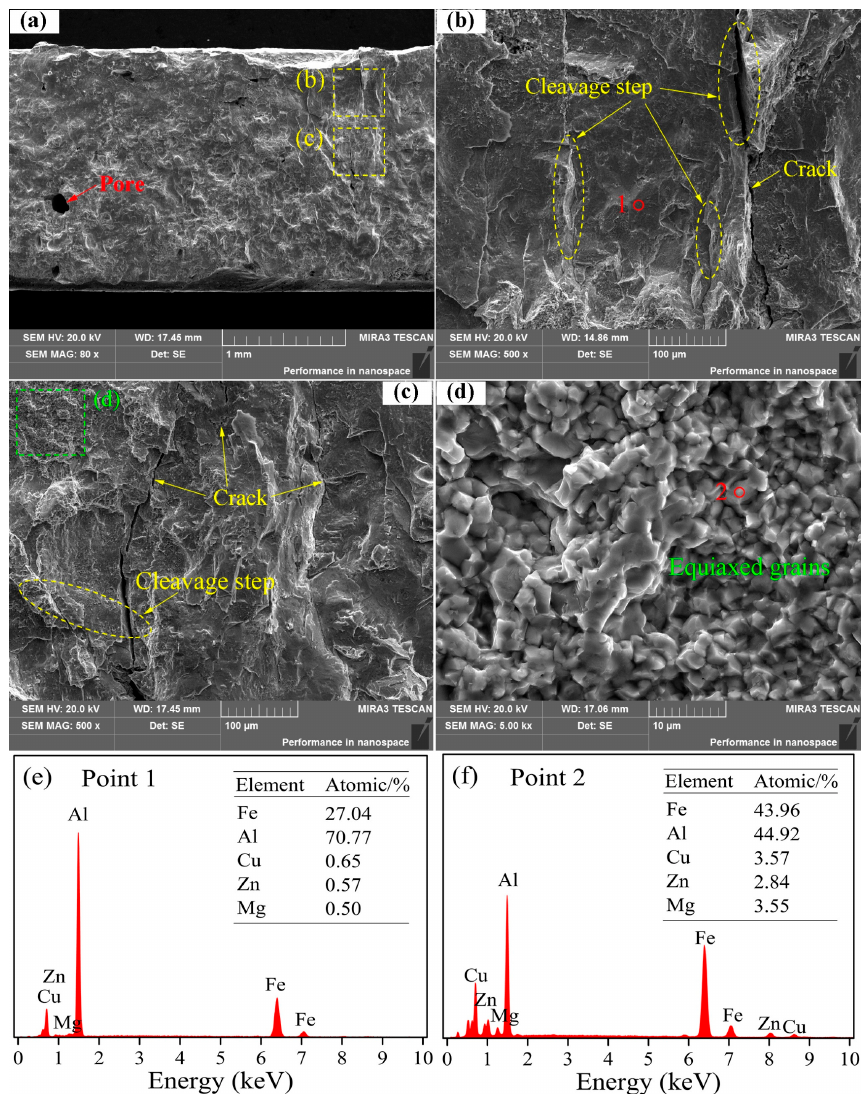
Figure 9. Fracture surface of the welded joint with a brass interlayer of 0.05 mm. ( a ) Overall fracture on the aluminum side, ( b , c ) magnified views of the regions with the dotted square in ( a ), ( d ) a magnified view of the region with the dotted square in ( d ), and ( e ) and ( f ) the EDS results of point 1 and 2 as marked in ( b ) and ( d ), respectively.